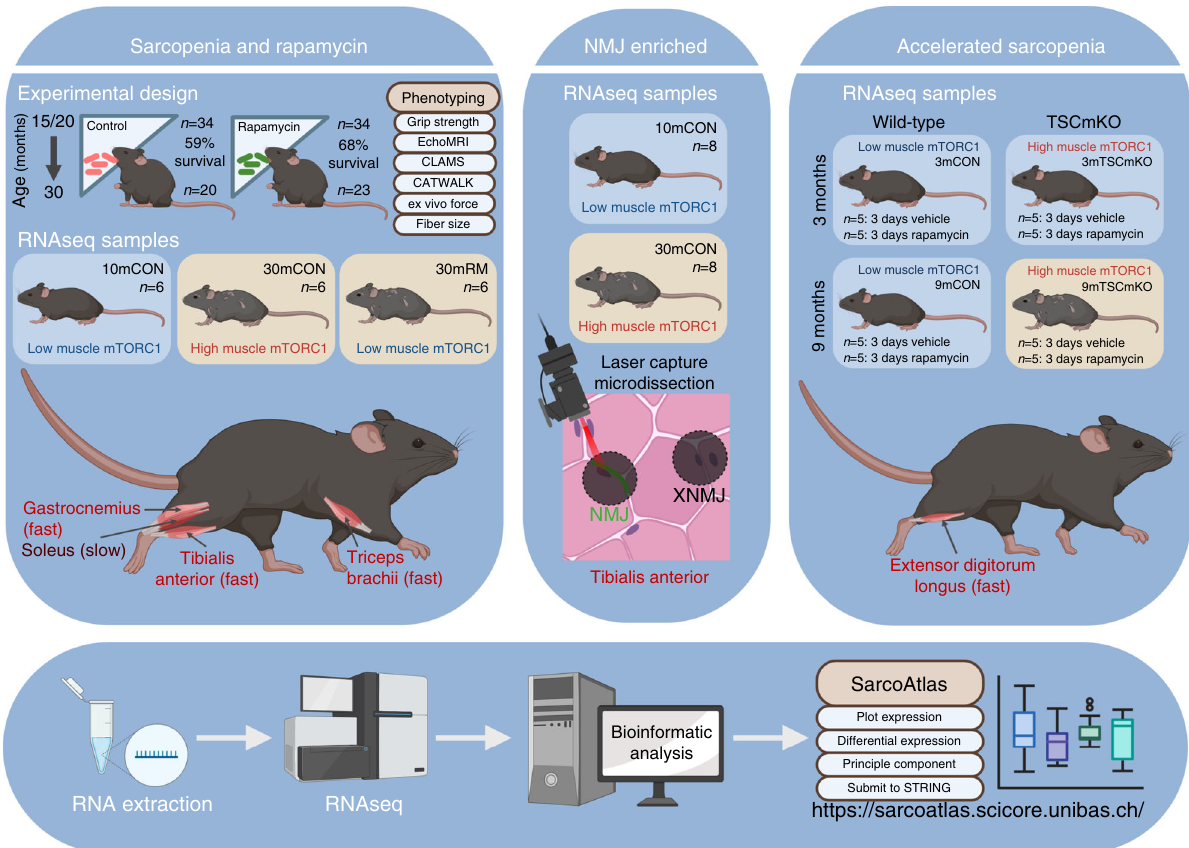
Fig. 8 SarcoAtlas. A graphical representation of the experimental design, group numbers, treatment duration, and muscles analyzed for the three novel data sets generated, analyzed, and available through the user-friendly SarcoAtlas application (https://sarcoatlas.unibas.ch/). SarcoAtlas allows interested users to plot and extract expression data for a gene of interest, and perform principal component or differential expression analysis on any of the three novel data sets: (1) sarcopenia and rapamycin, (2) laser-capture microdissection of NMJ-enriched and non-NMJ (XNMJ) regions, and (3) TSCmKO model of accelerated sarcopenia. Furthermore, gene lists can be easily submitted to string to visualize interactions and investigate gene ontology. Figure created with